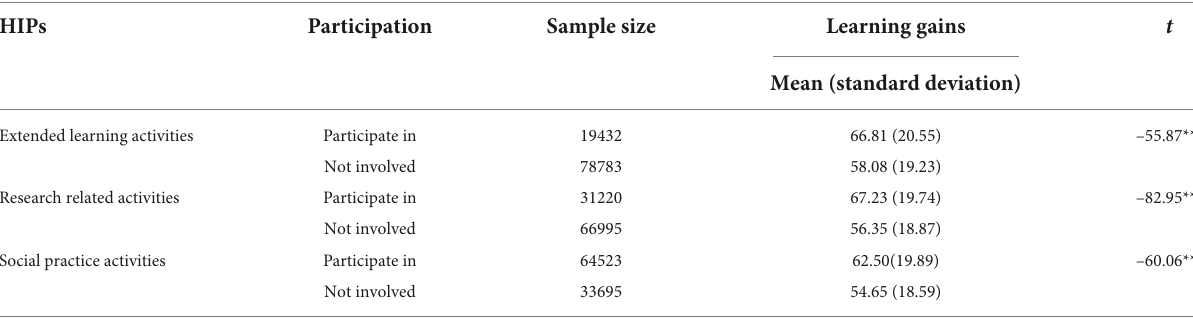
TABLE 4 Analysis of differences in educational practices of students whether they participate in